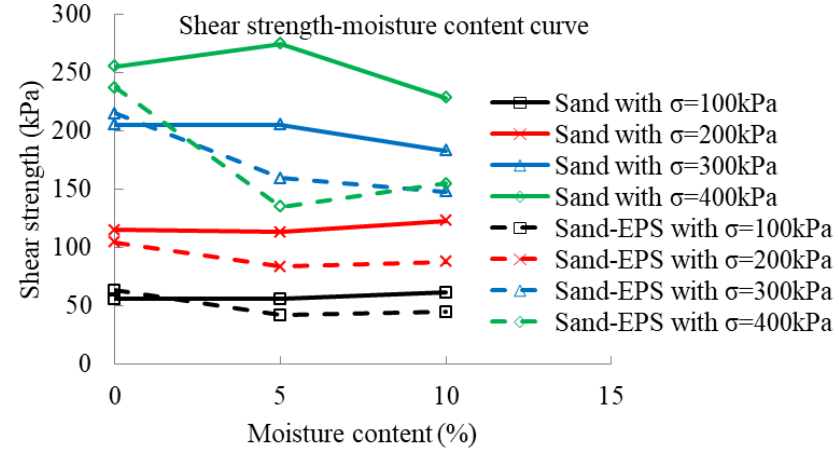
Figure 7. Shear-strength – moisture content curves under different normal stresses.